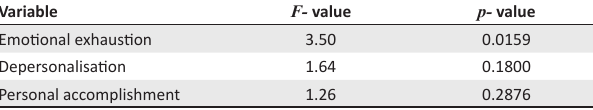
TABLE 8: Results of the one-way analysis of variance, with experience as the independent variable, on the three Maslach Burnout Inventory subscales. Variable F- value p- value Emotional exhaustion 3.50